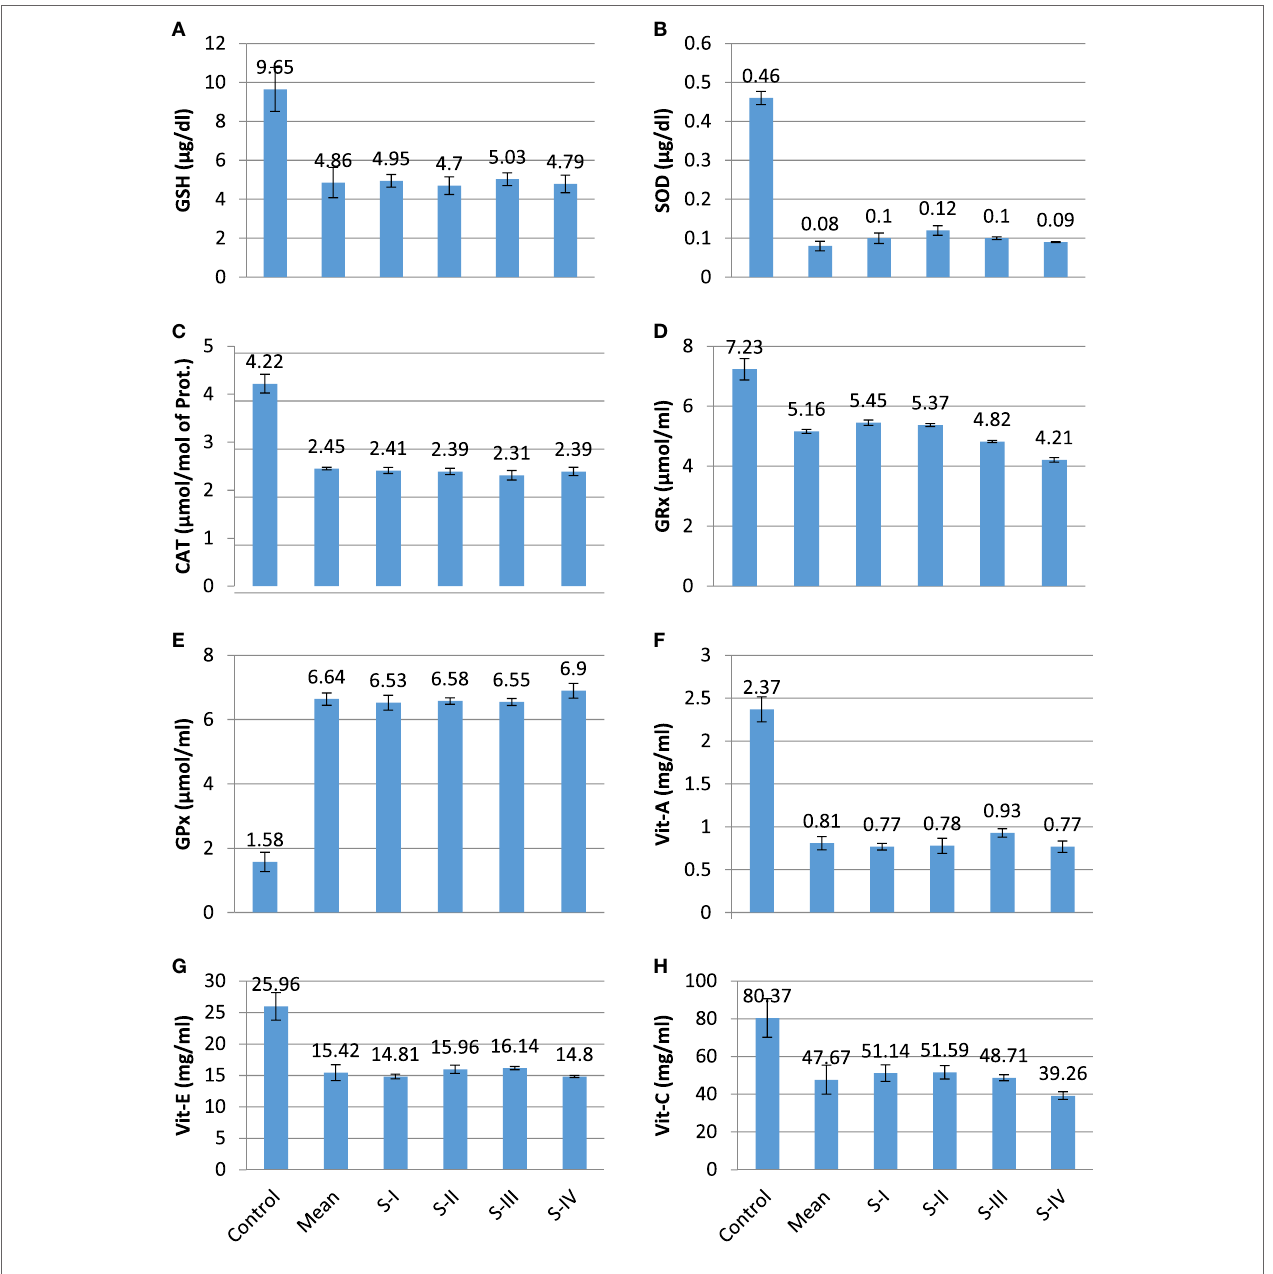
FigUre 1 | Profile of different prognostic variables in CA colorectal vs controls. (a) GSH ( μ g/dl); (B) superoxide dismutase (SOD) ( μ g/dl); (c) catalase (CAT) ( μ mol/mol of protein); (D) GRx ( μ mol/ml); (e) GPx (mmol/dl); (F) Vit A (mg/ml); (g) Vit E (mg/ml); and (h) Vit C